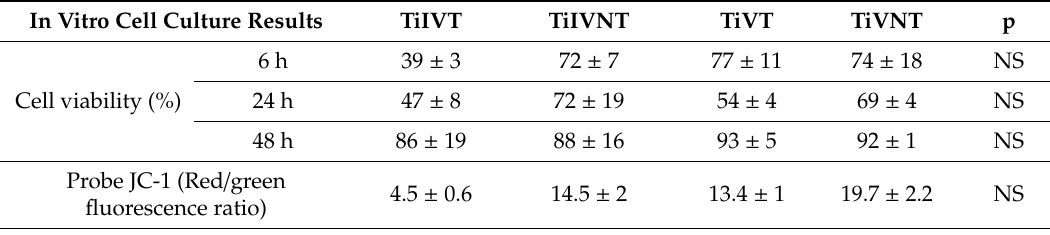
Table 2. In vitro cell culture results.